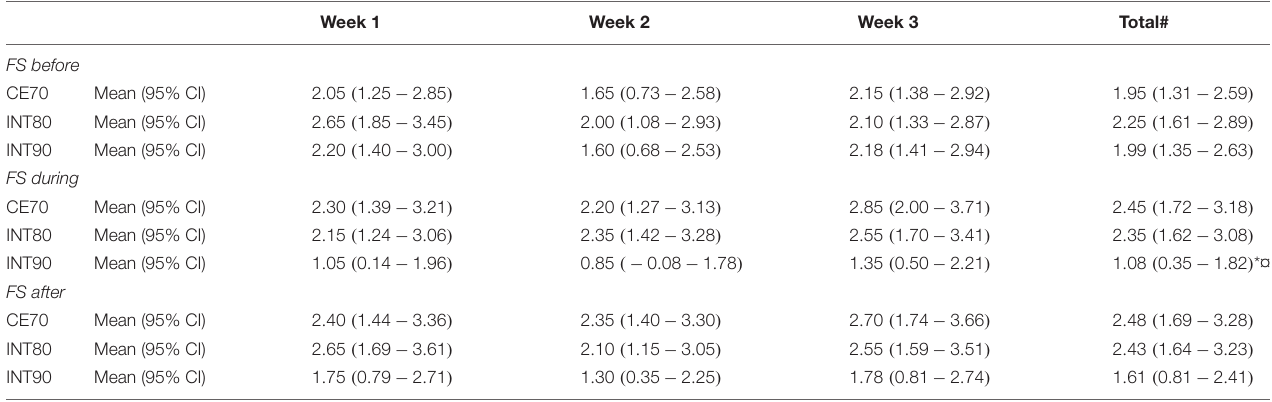
TABLE 2 | Feeling Scale responses before, during and after the exercise